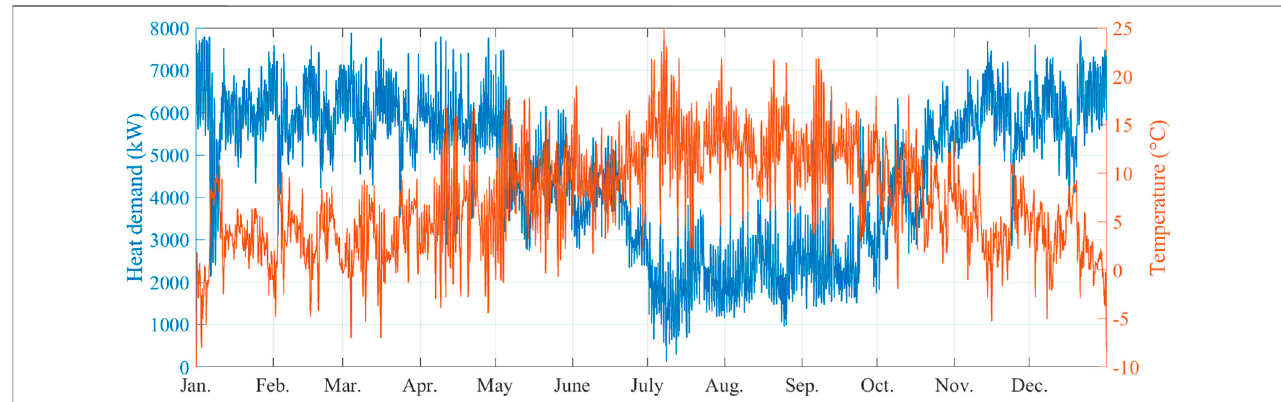
FIGURE 3 | Heat demand of university campus versus ambient